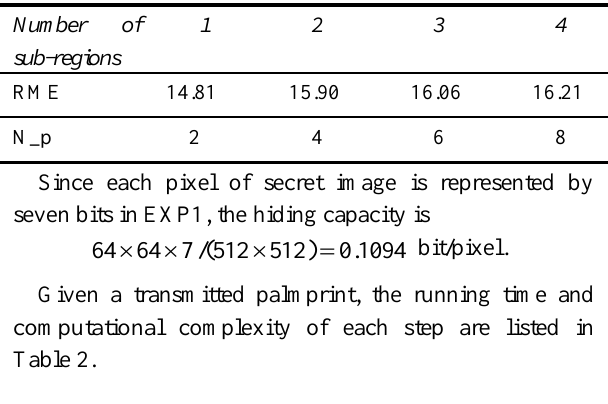
Table 2. The running time of each step.